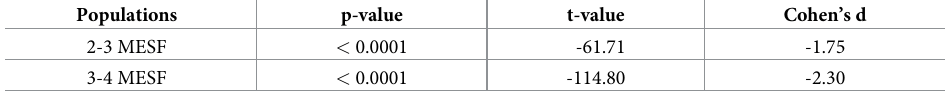
Table 2. Results of t-test and Cohen’s d for the fluorescence intensity of MESF level 2 against MESF level 3, and MESF level 3 against MESF level 4.